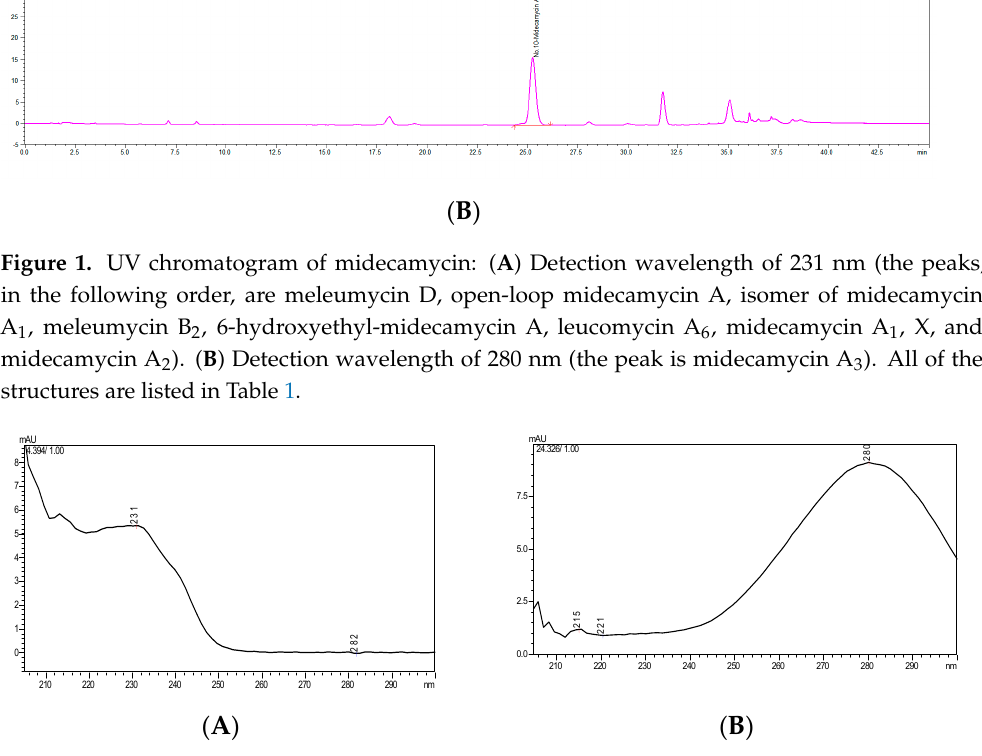
Figure 2. Typical UV spectra: ( A ) meleumycin D (with the maximum absorption at 231 nm); ( B ) midecamycin A 3 (with the maximum absorption at 280 nm). All of the UV spectra of impurities and components are shown in Figure S2.